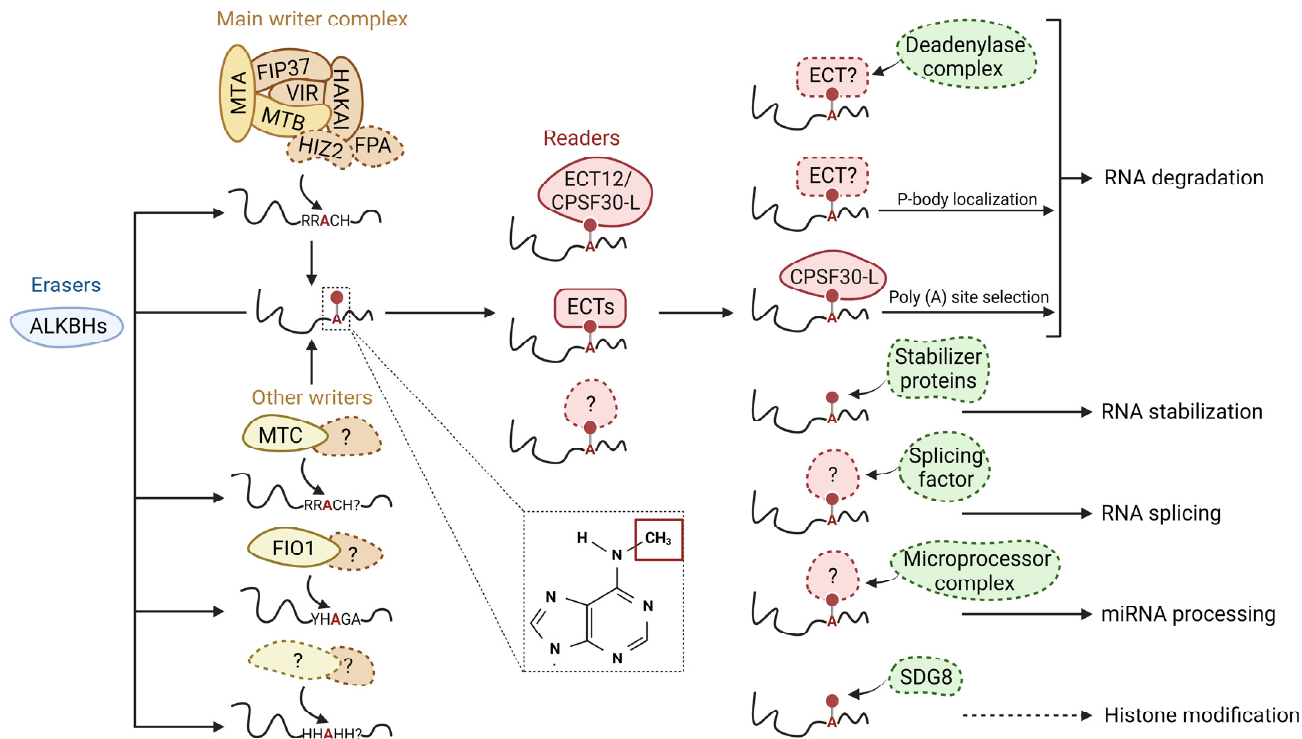
Figure 1. Schematic model of m 6 A modifications and its regulatory roles in RNA metabolism. m 6 A writers, erasers, readers, and other proteins/protein complexes are illustrated in yellow, blue, red, and green, respectively. The colorful circles with dashed lines indicate unidentified/unconfirmed components/factors/regulations in the plant system. m 6 A writers install a methyl group at the N-6 position of an adenosine base after binding to the RRACH (R = G/A; H: U/A/C) consensus sequence. Various plant writers have been identified along with their homologs in the animal system. The presence of other plant writers and motifs, should they exist, remains to be identified. m 6 A modifications can be removed enzymatically by erasers. Plant erasers contain only members from the ALBHKs family. m 6 A readers are responsible for recognizing m 6 A-containing transcripts. Plants readers include members from the ECT family and CPSF30. Structural changes in RNA after m 6 A modification or the recognition of m 6 A modifications by m 6 A readers can facilitate or inhibit the